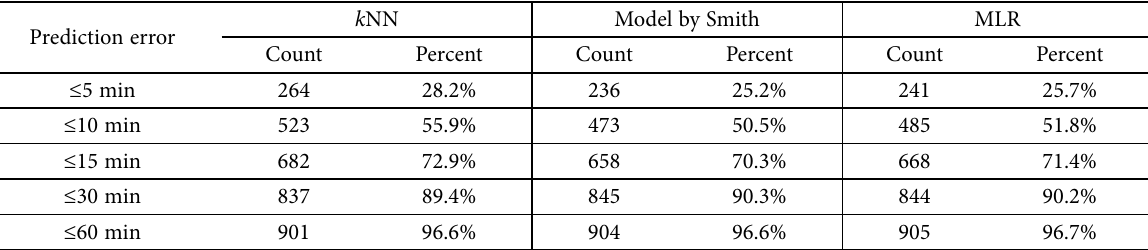
Table 7. Percent of records within a given tolerance of prediction